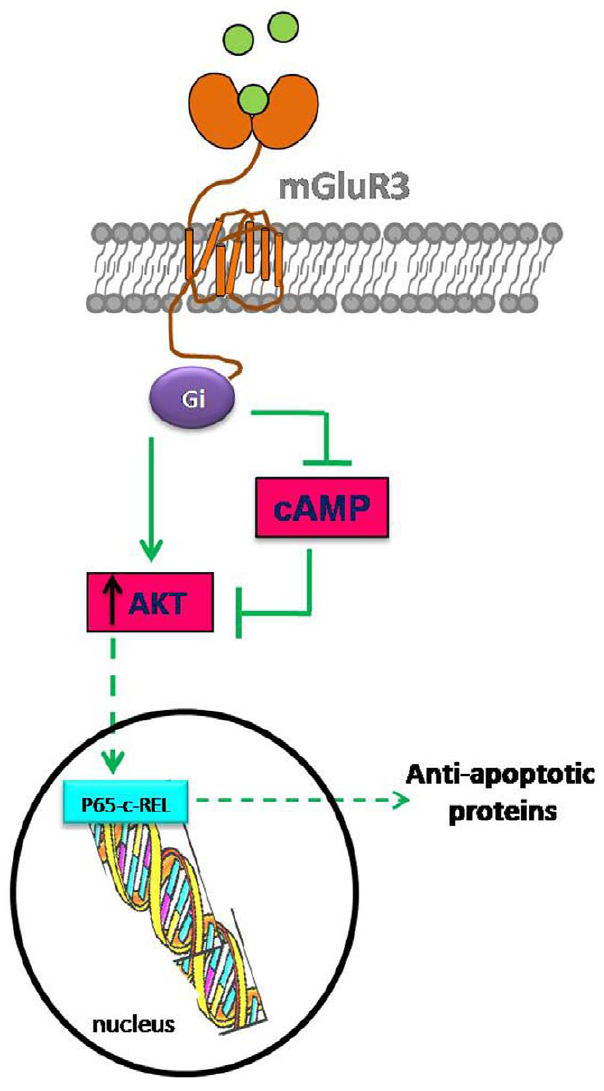
Figure 8. Proposed model for mGluR3 protective actions in astrocytes. mGluR3 activation by selective ligands couples to Gi protein activation, which can inhibit adenylyl cyclase activity and cAMP production and/or directly activate PI3K/Akt pathway. Alternatively, cAMP reduction could lead to Akt activation, because cAMP inhibits Akt phosphorylation. In turn, Akt might induce p65-c-Rel interaction at nucleus, which stimulates the transcription of anti-apoptotic genes such as Bcl-2, resulting in astrocyte protection from NO challenge.